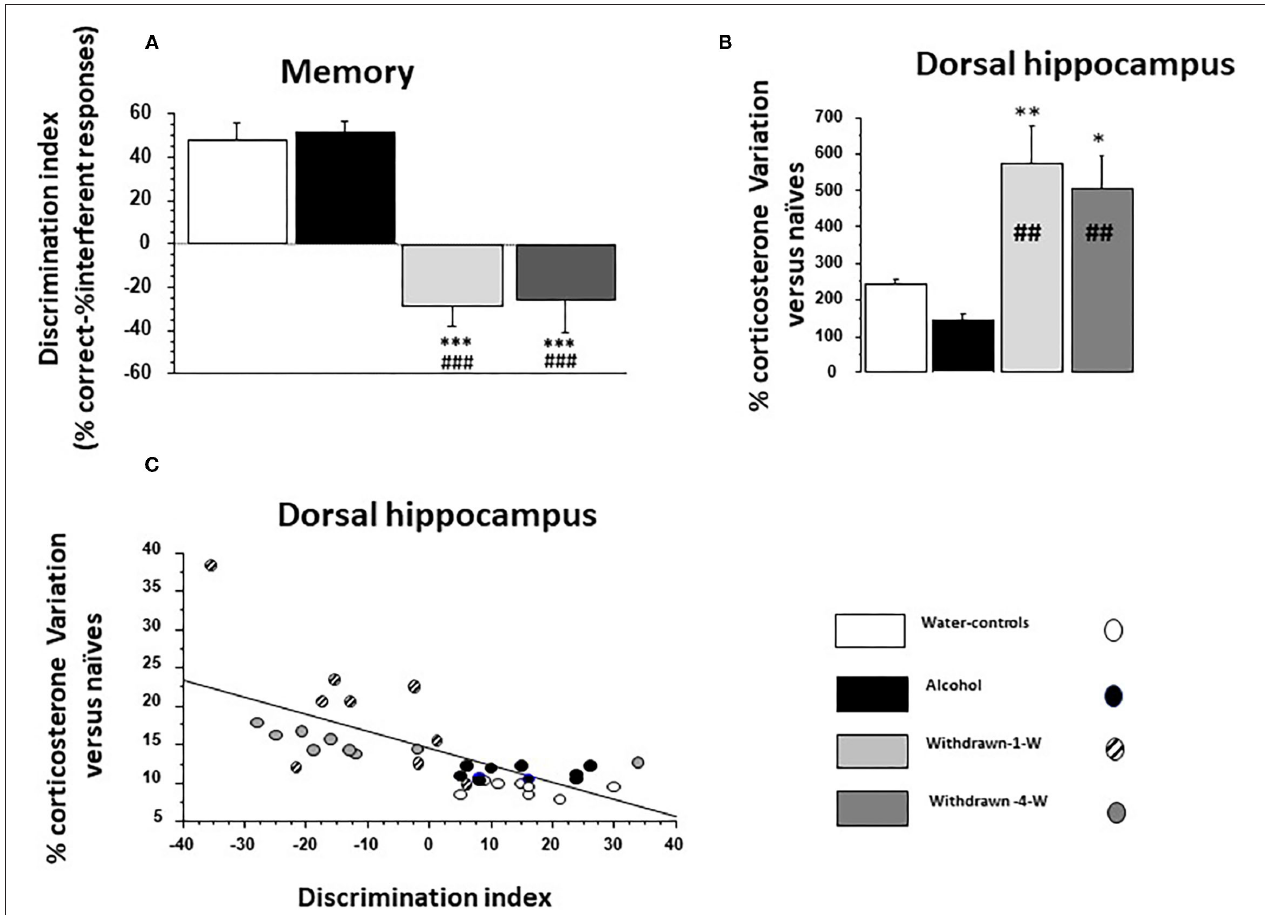
FIGURE 4 | (A) Memory: the discrimination index is significantly lowered in both 1- and 4-W withdrawn groups as compared to both the water-control group (*** p < 0.001) and the Alcohol group (### p < 0.001); (B) % test-induced increases of corticosterone concentration (TICC) in the dorsal hippocampus (dHPC) from naïve condition; as can be observed, 1- and 4-W withdrawn mice exhibited a lower TICC score as compared to water-controls (** and *: p < 0.01 and p < 0.05, respectively) and to Alcohol mice (## p < 0.01 in both comparisons); (C) Regression analysis between individual TICC score in the dHPC and discrimination index in water-controls (white circle), alcohol (black circles), 1-W (hashed gray circles), and 4-W (hashed dark gray circles) groups. A significant negative correlation was observed, the higher being the TICC score, the lower being the index discrimination.